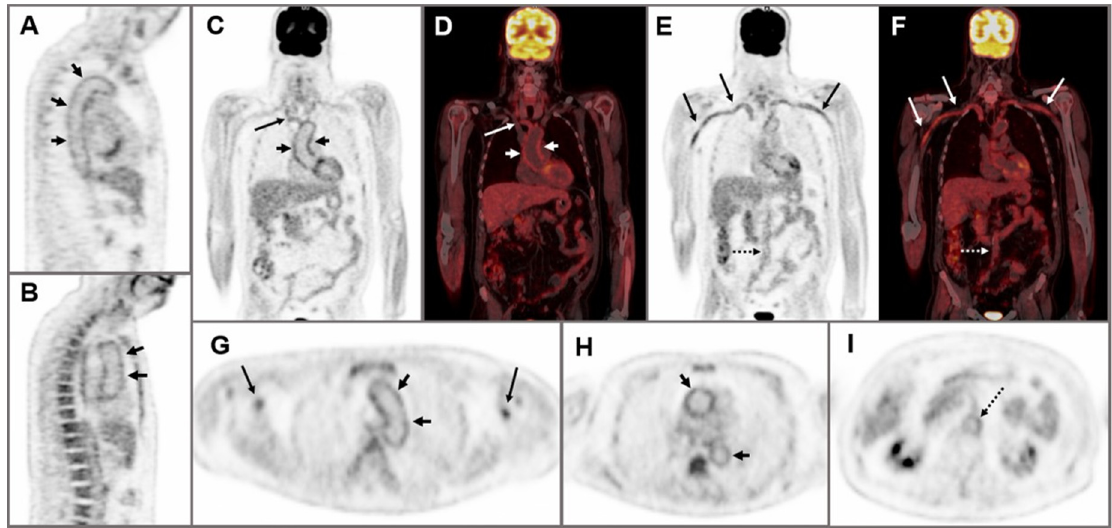
Figure 2. A 63-year-old man with a 4-month history of right hemicranial headache, scalp hyperalgesia, asthenia, weight loss, and increased erythrocyte sedimentation rate and serum C-reactive protein levels. Sagittal PET ( A , B ), coronal PET and fused PET/CT ( C – F ), and axial PET images ( G – I ) showed hypermetabolism along the vessel wall of the brachiocephalic trunk, subclavian and axillary arteries (arrows), thoracic aorta (short arrows) and abdominal aorta (dotted arrow), suggesting large vessel vasculitis. Temporal artery biopsy was positive for giant cell arteritis.